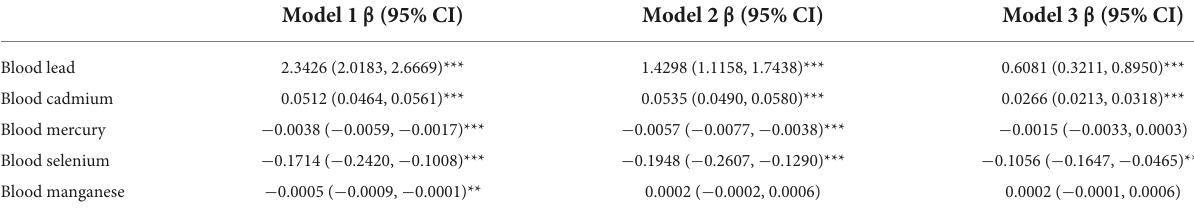
TABLE 3 Association between trace mineral concentration ( µ mol/L) and CAL